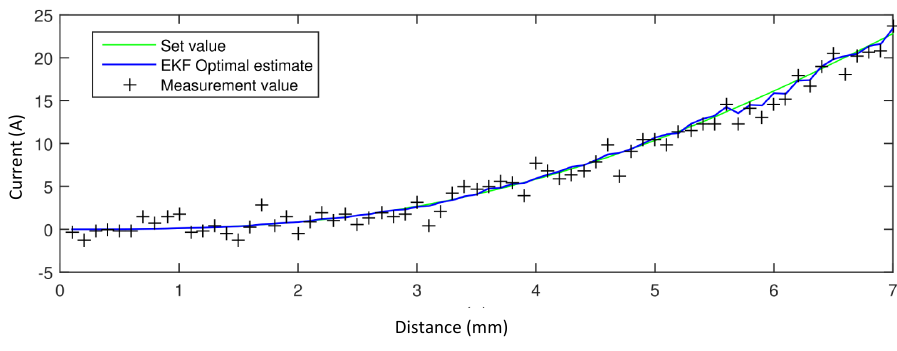
Figure 8. The effect of a current profile filtered by EKF .